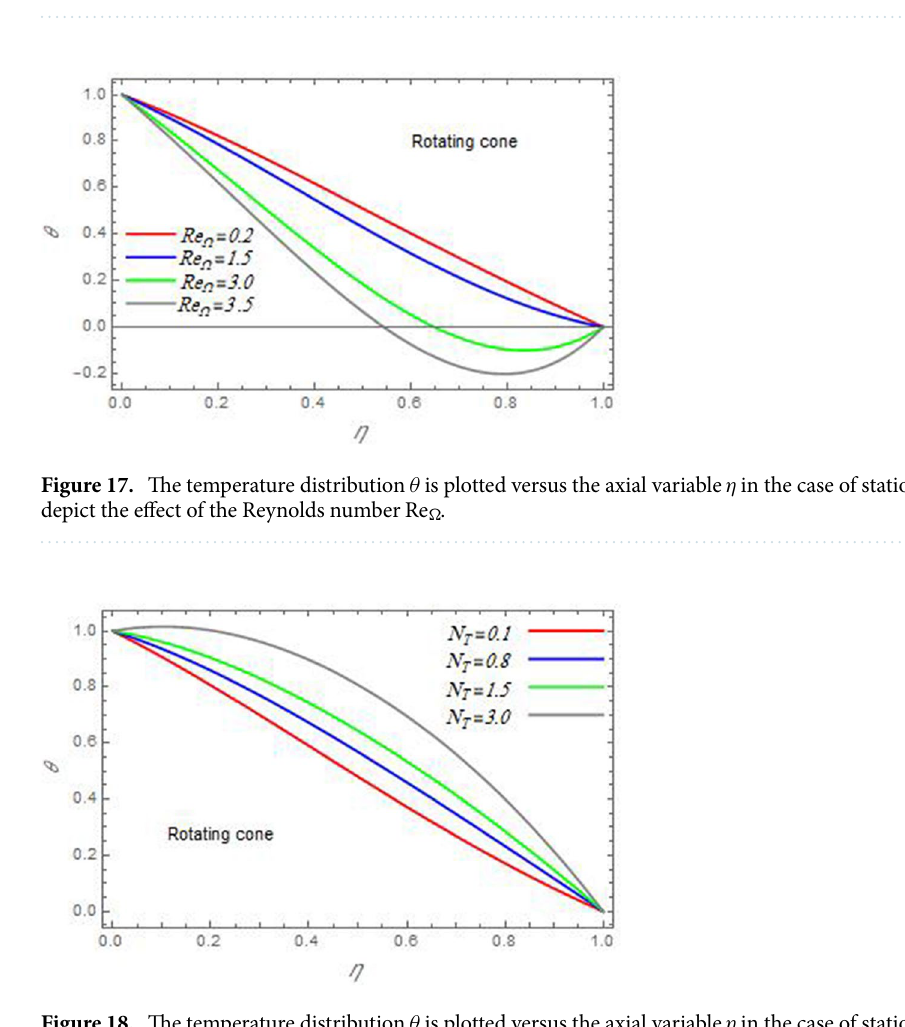
Figure 16. The temperature distribution θ is plotted versus the axial variable η in the case of stationary cone to depict the effect of the Reynolds number Re ω .